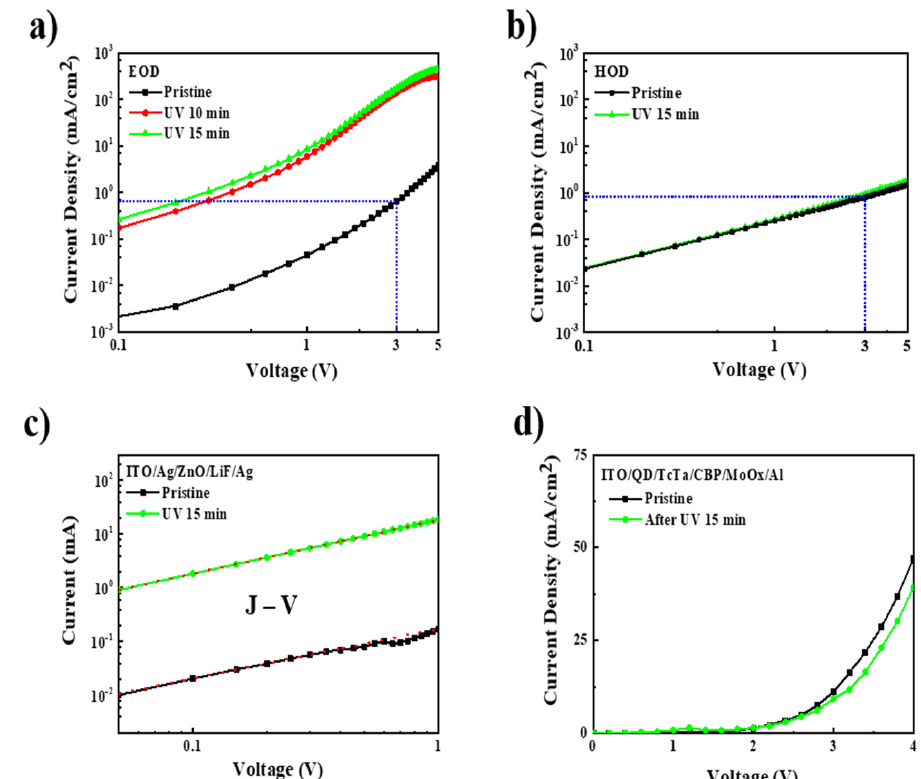
Figure 2. ( a ) J–V curves for electron-only devices (ITO/ZnO/QDs/ZnO/Al); ( b ) J–V curves for hole-only devices (ITO/PEDOT/TFB/QDs/TcTa/CBP/MoO x /Al); ( c ) J–V characteristics of electron devices (ITO/Ag/ZnO/LiF/Ag). The red dotted line exhibits the ohmic region of J–V; ( d ) J–V curves for the device without a ZnO layer.